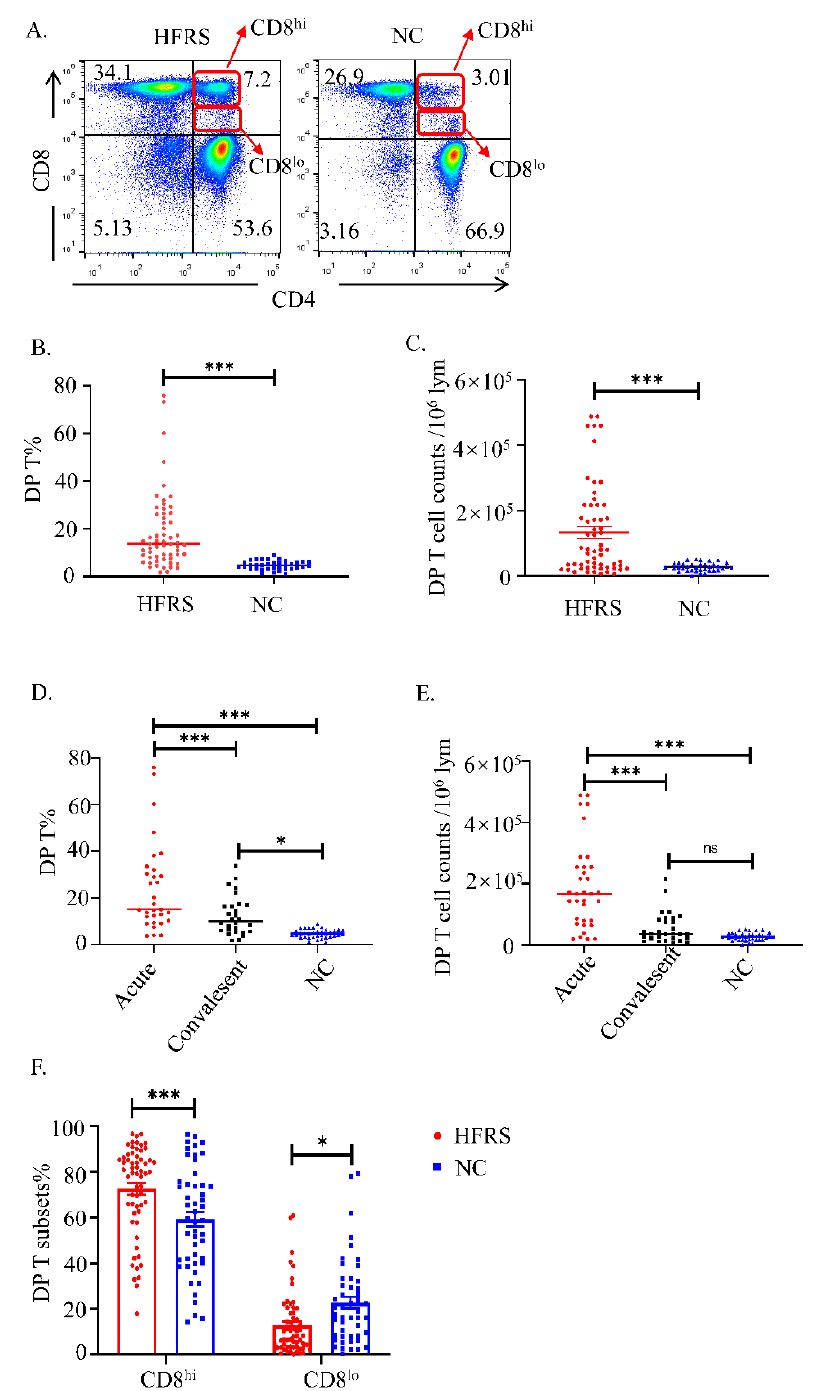
Figure 1. The kinetic changes of DP T cells in HFRS patients. ( A ). The representative flow cytometric plots of DP T cells in both HFRS patients and normal controls (NC). The gradually changing of the dots ‘colors indicated the cell density. The red color indicated the high cell density, while the blue color indicated the low cell density. Summary data of the comparison of the ( B ) percentage and ( C ) cell counts of DP T cells in HFRS patients and NC. Summary data of the comparison of the ( D ) percentage and ( E ) cell counts of DP T cells in different phases (acute phase and convalescent phase) of HFRS patients and NC. ( F ) The comparison of CD8 hi and CD8 lo subsets of DP T cells in HFRS patients and NC (For HFRS, n = 59; For NC, n = 36). * p < 0.05; *** p < 0.001.